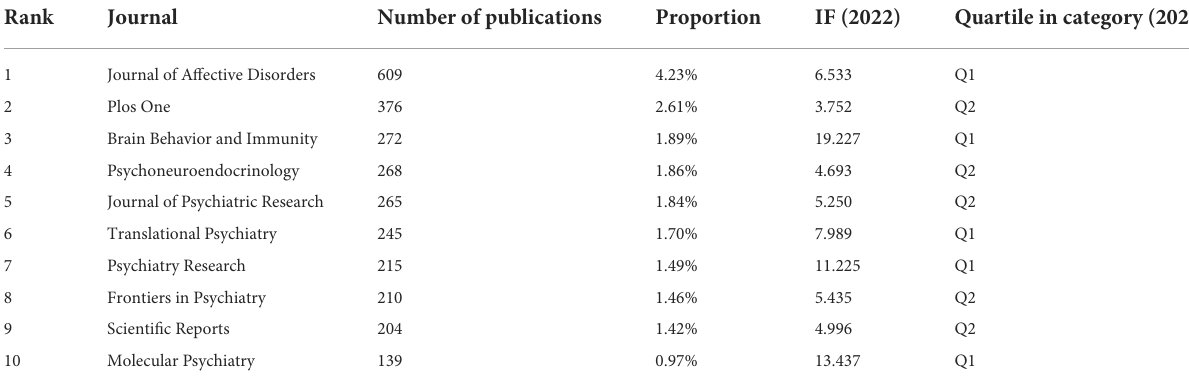
TABLE 2 The top 10 highly-productive journals in depression biomarker research.